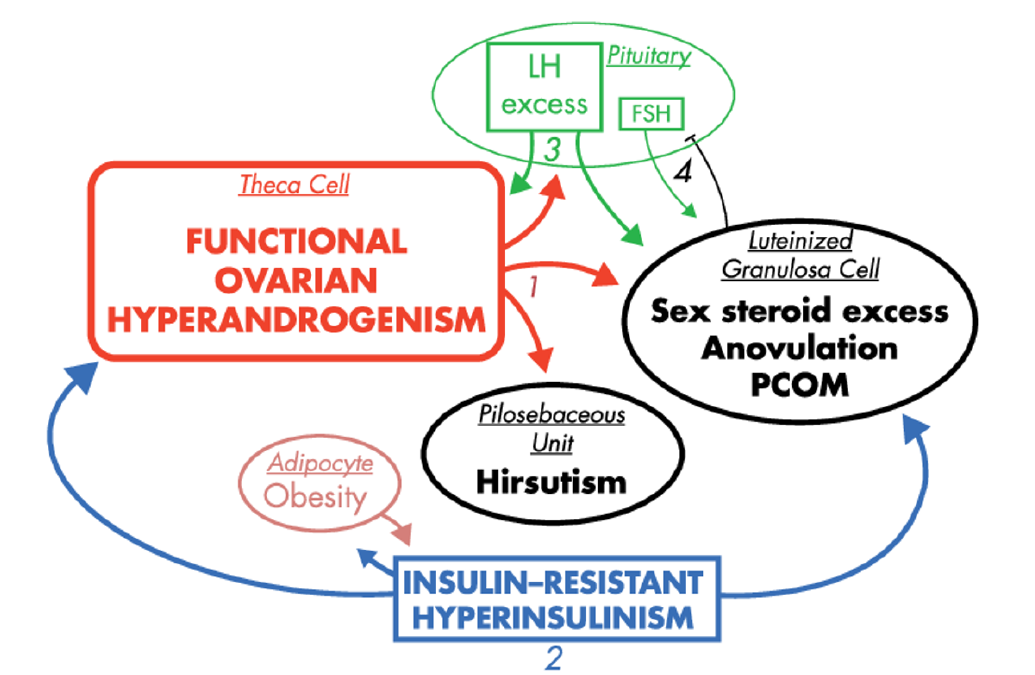
Figure 3. The effects of hyperinsulinemia in the context of PCOS pathogenesis, reprinted and captioned from [42] with permission of the Oxford University Press. Ovarian